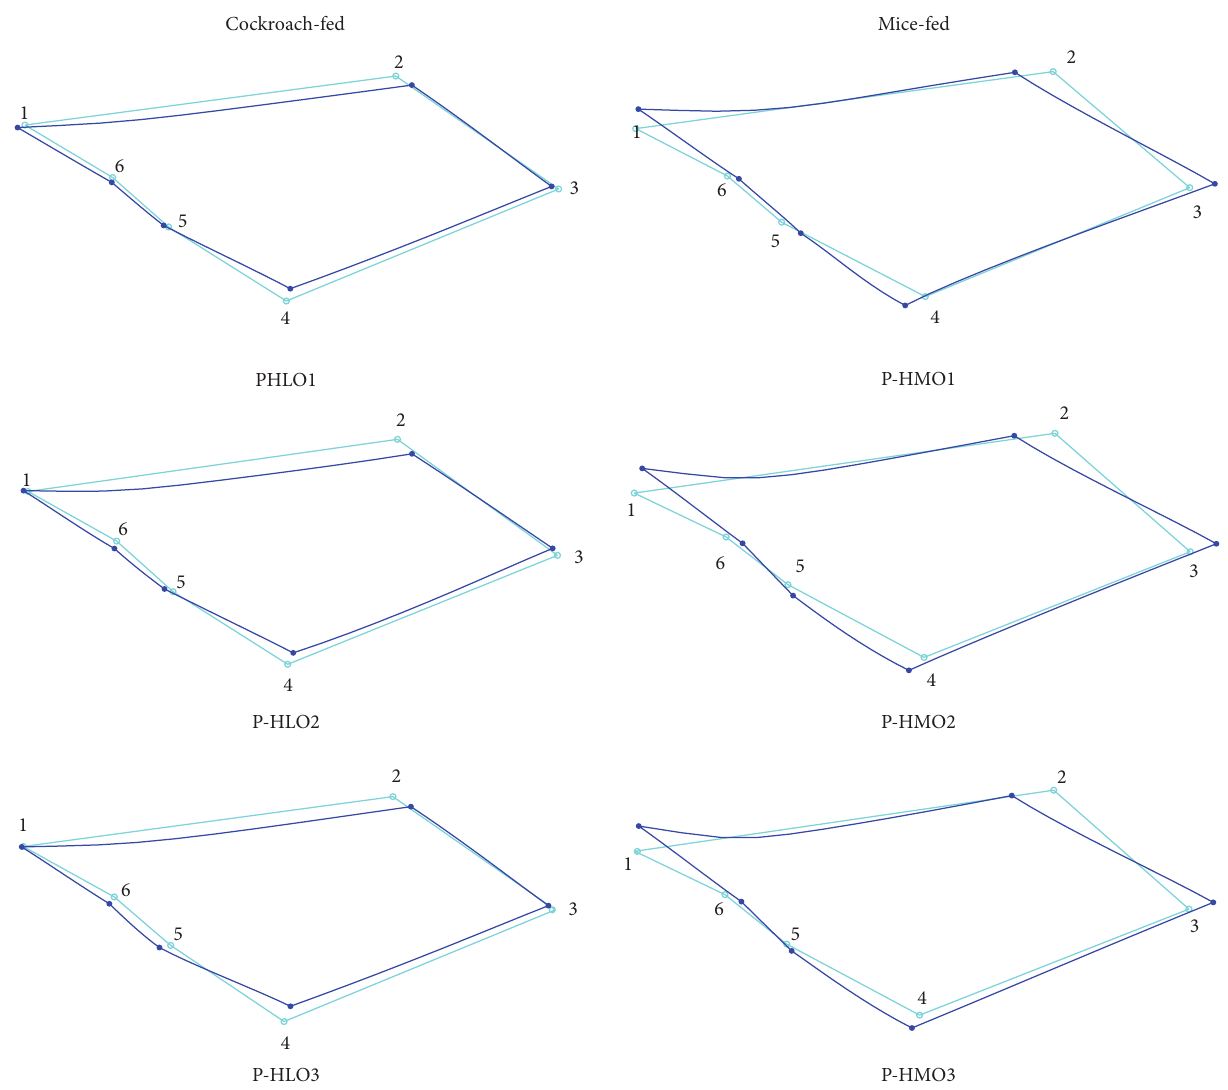
Figure 4: Wing deformation caused by superimposing the offspring shape on the parental shape. The sky blue configuration refers to the